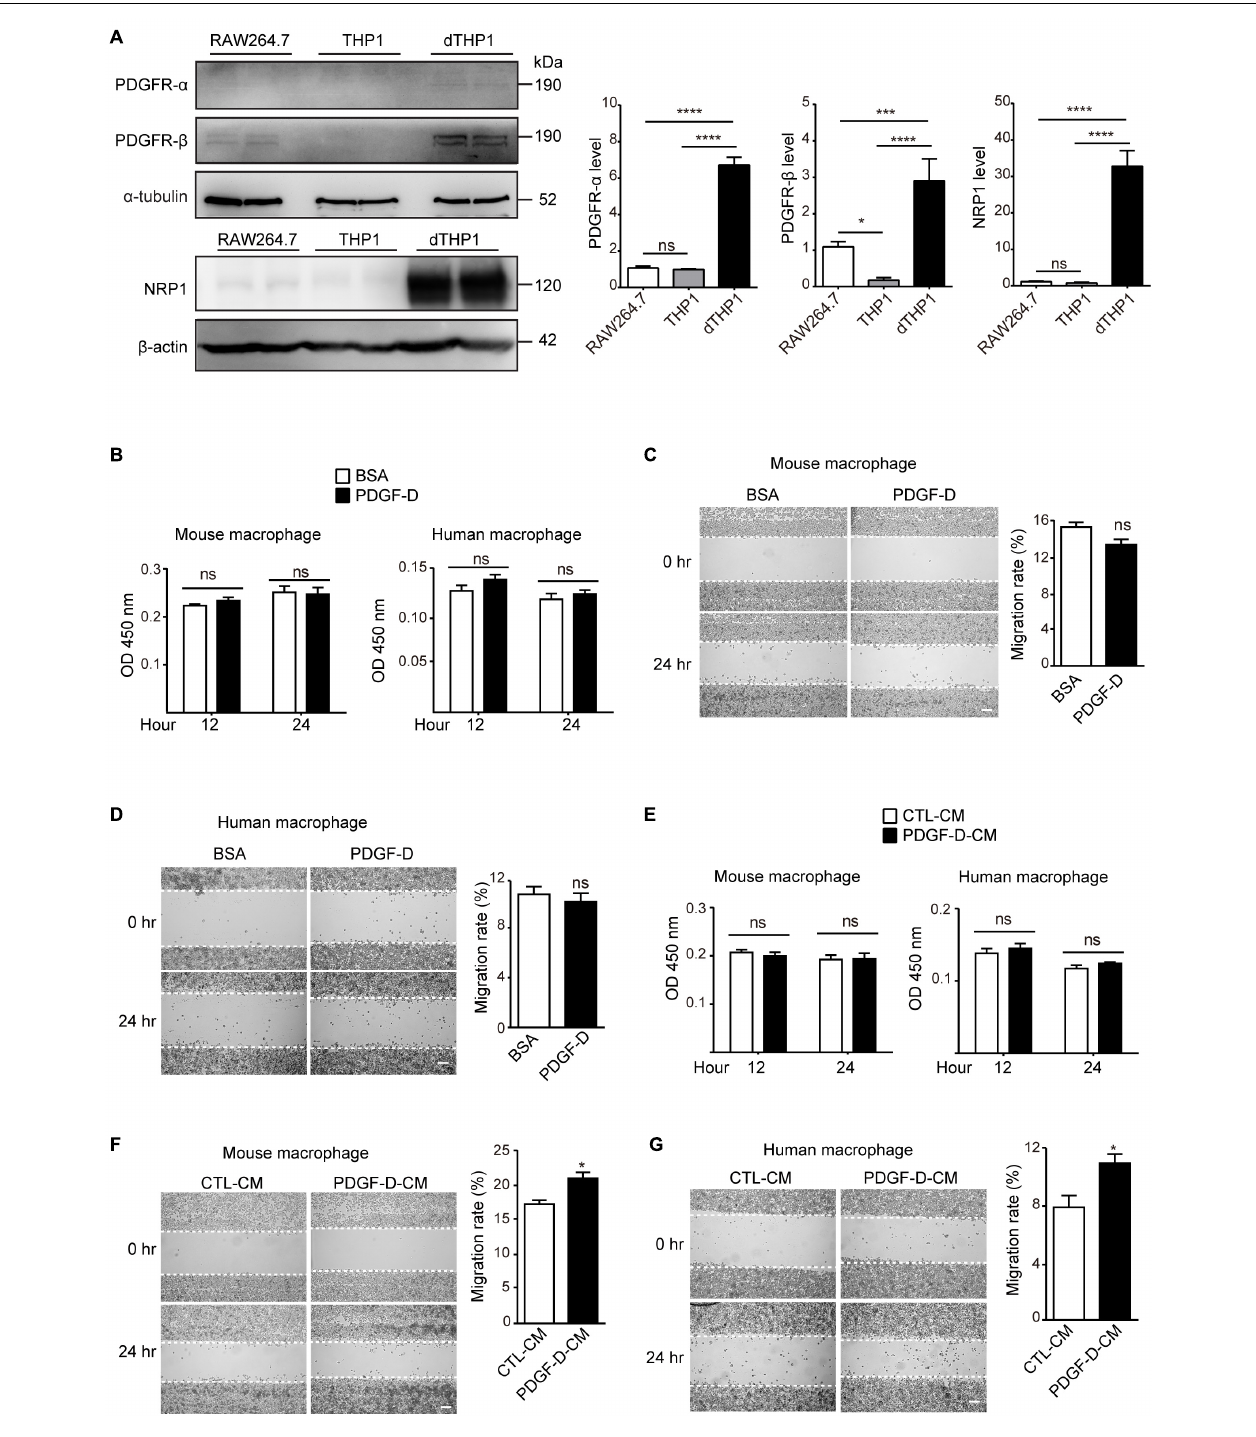
FIGURE 1 | Effect of PDGF-D on macrophage proliferation and migration. (A) Immunoblotting showing the expression of PDGFR- α , PDGFR- β and NRP1 in RAW264.7 mouse macrophages, THP1 human monocytes and dTHP1 human macrophages. (B) Proliferation of mouse and human macrophages treated with PDGF-D protein for 12 or 24 h. (C,D) Migration of mouse (C) and human (D) macrophages stimulated with PDGF-D protein for 24 h. (E) Proliferation of mouse and human macrophages treated with conditioned medium from PDGF-D-treated HRPE cells (PDGF-D-CM). Conditioned medium from HRPE cells without PDGF-D treatment (CTL-CM) was used as a control. (F,G) Migration of mouse (F) and human (G) macrophages treated with conditioned medium from PDGF-D-treated HRPE cells (PDGF-D-CM). Conditioned medium from HRPE cells without PDGF-D treatment (CTL-CM) was used as a control. Scale bars: 400 µ m. All the experiments were performed in triplicates. Unpaired two-tailed Student’s t -test was used for statistical analysis. * p < 0.05, *** p < 0.001, **** p < 0.0001, ns: not significant.